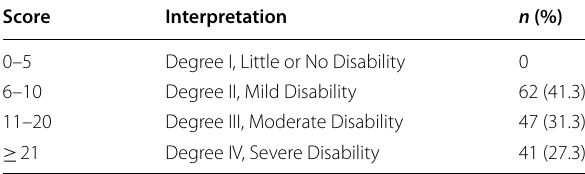
Table 2 The impact of migraine on students’ quality of life based on the MIDAS score, n =